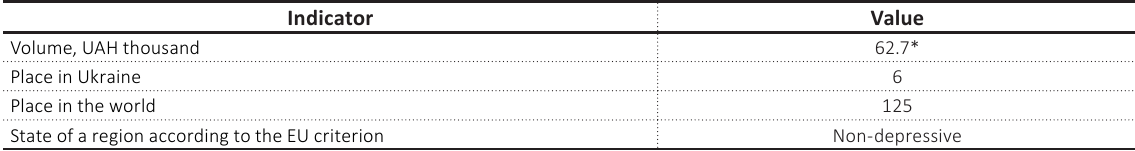
Table 2. Gross regional product per